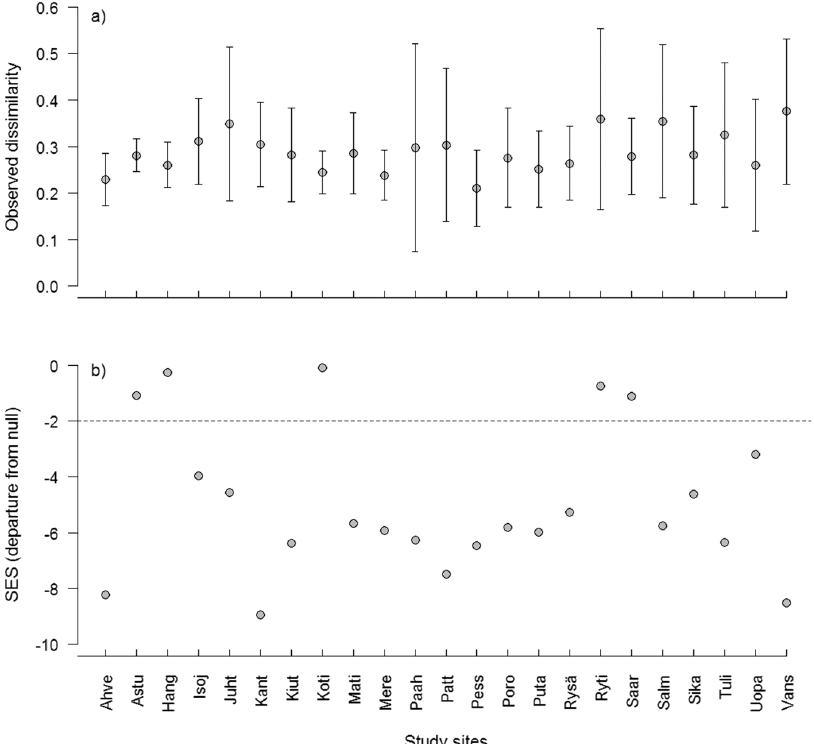
Figure 1. Site-specific temporal β diversity. The mean ( ± 1 SD) among-year dissimilarity, calculated for consecutive year pairs, for each study site expressed as ( a ) observed dissimilarity (Bray-Curtis index) and as ( b ) departure from null expectation. The dashed line represents the limit below which a community is interpreted as being more stable than expected by chance ( β dep < − 2). Above the line, variation in community composition does not differ from random expectation.